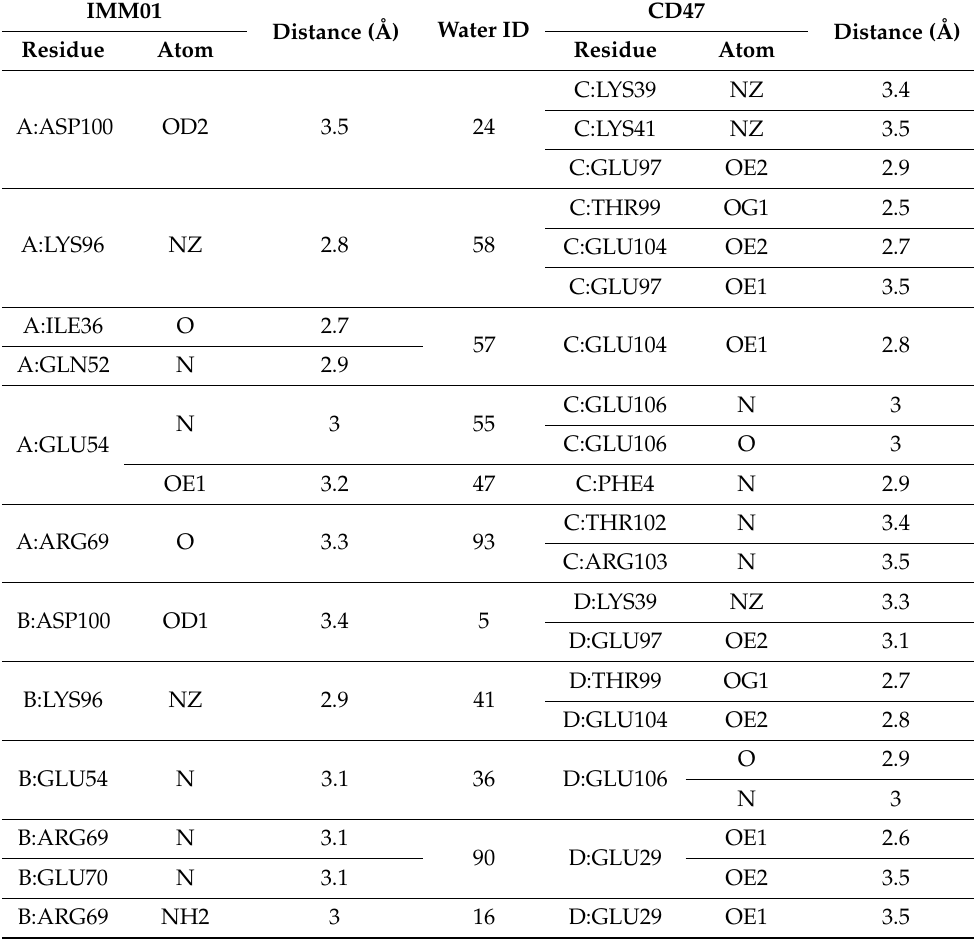
Table 3. Water-mediated hydrogen bonds between IMM01 and